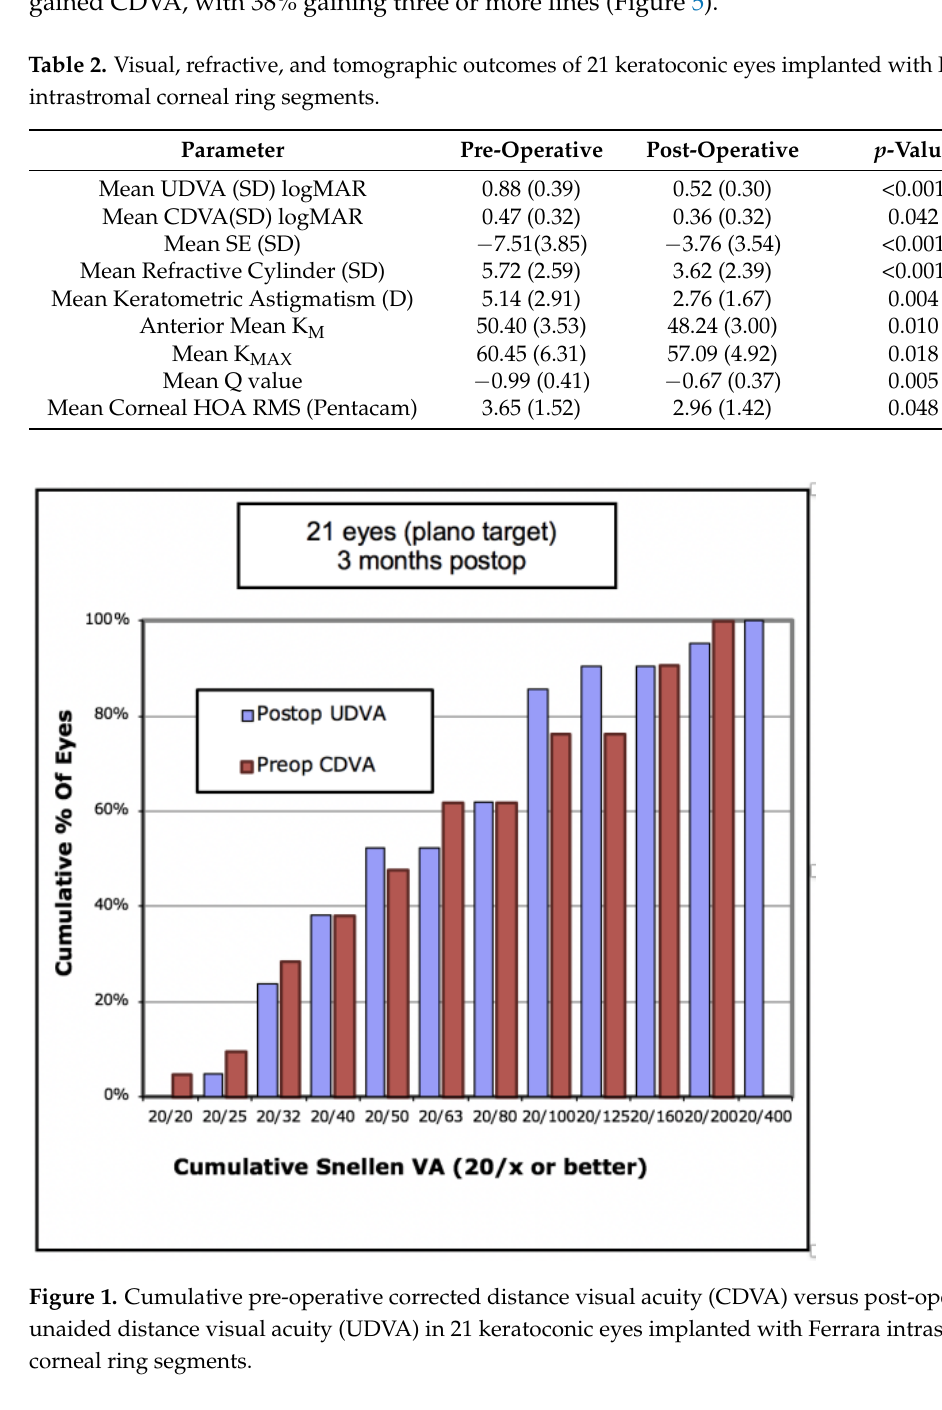
Figure 2. Cumulative pre-operative versus post-operative unaided distance visual acuity (UDVA) in 21 keratoconic eyes with Ferrara intrastromal corneal ring segments.